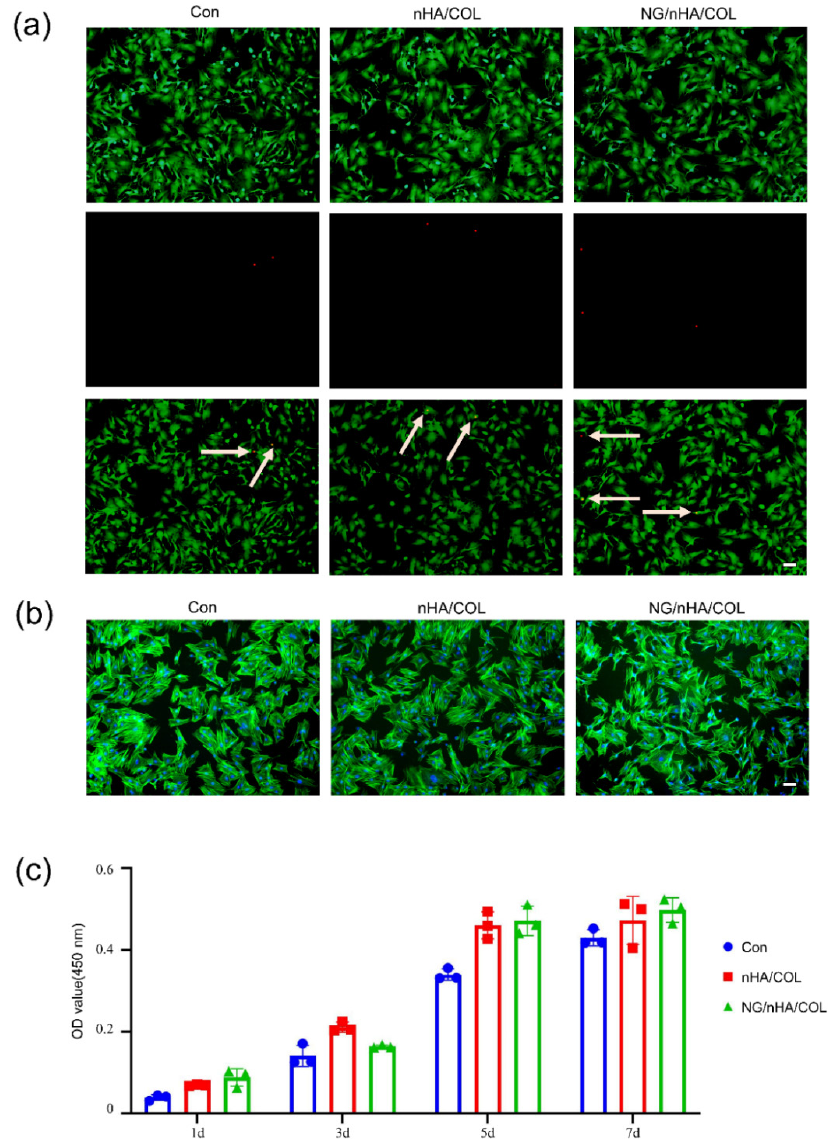
Figure 4. In vitro biocompatibility investigation of NG/nHA/COL. BMSCs were cultured with nHA/COL and NG/nHA/COL culture media extracts. ( a ) After 24 h incubation, the live/dead staining of BMSCs in control, nHA/COL, and NG/nHA/COL groups (scale bar: 200 µm). ( b ) After 24 h incubation, phalloidin and DAPI proliferation staining of BMSCs in control, nHA/COL, and NG/nHA/COL groups (scale bar: 200 µm). ( c ) Proliferation of BMSCs of control, nHA/COL, and NG/nHA/COL groups analyzed by CCK ‐ 8 kit (n = 3).